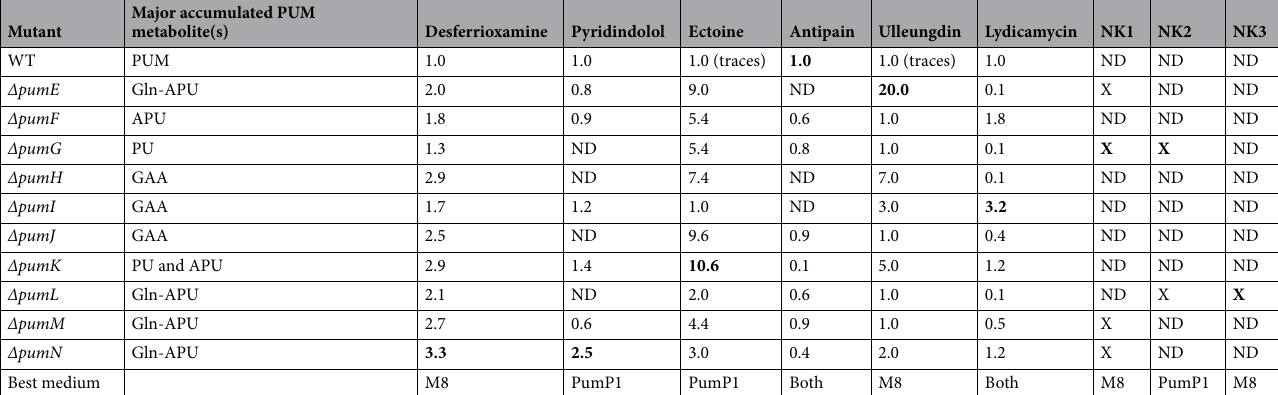
Table 3. Relative amounts of the identified metabolites in the different pum mutants. Amounts are expressed as ratios to those observed in the WT strain in the same medium. Note that for NK1 through NK3, which are not detected in the WT, their presence is indicated with an "X". The highest relative amounts of metabolites are in bold type.